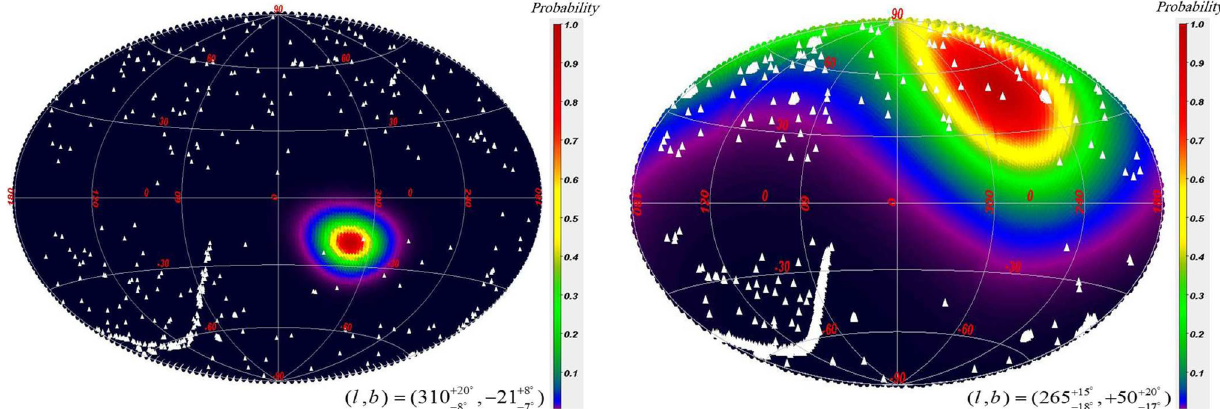
Fig. 4 Probability of dark energy dipole direction using 2 × 10 5 for (cid:2) CDM Model Left:Union2+GRB data , Right:Pantheon data. White triangles denote Union2+GRB